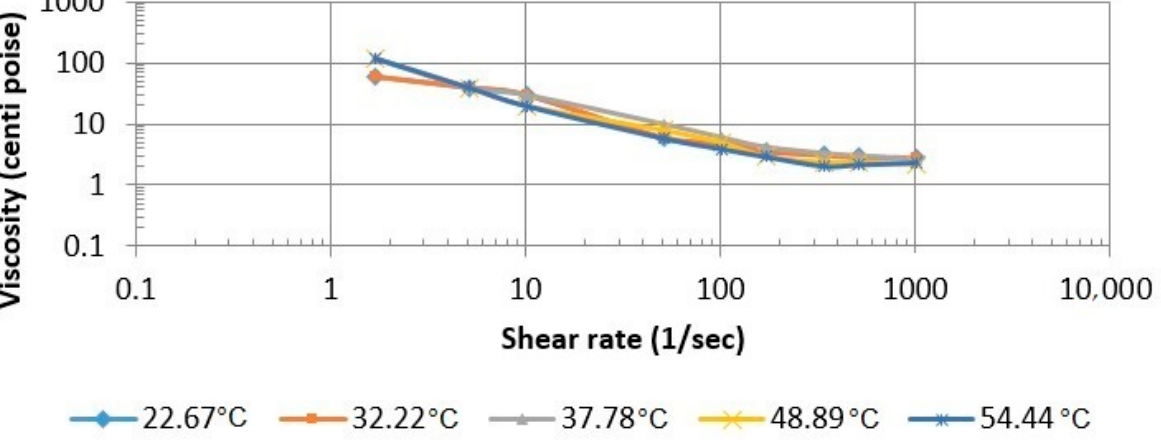
Figure 10. Effects of temperature on the viscosity of the SP and butanone blend.